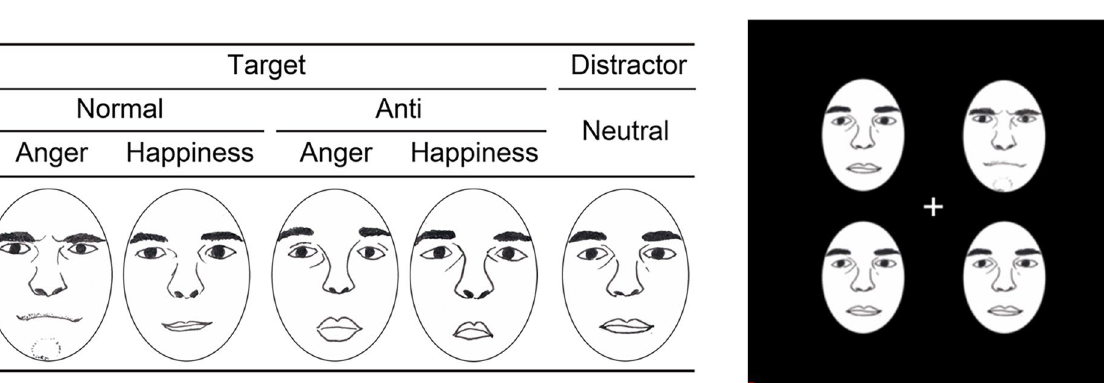
Stimulated hemisphere